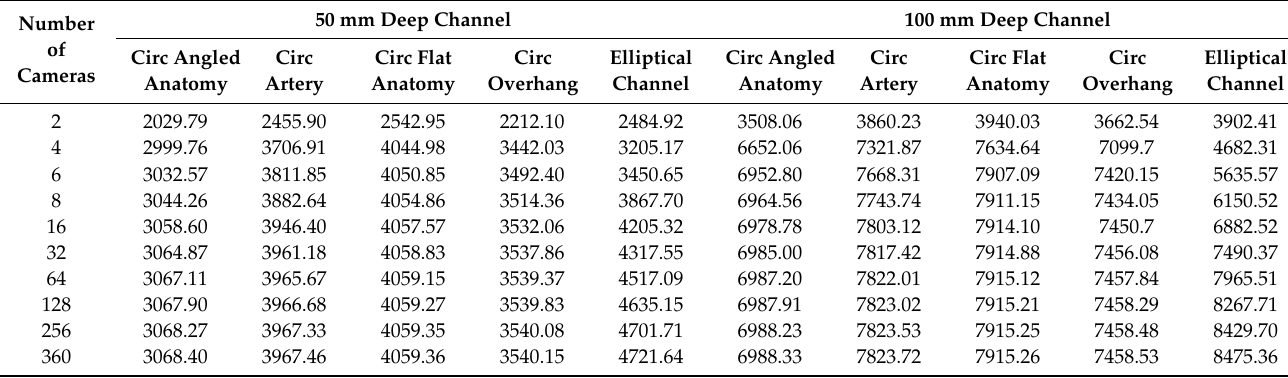
Table A2. Absolute values of the models excluding the mesh top